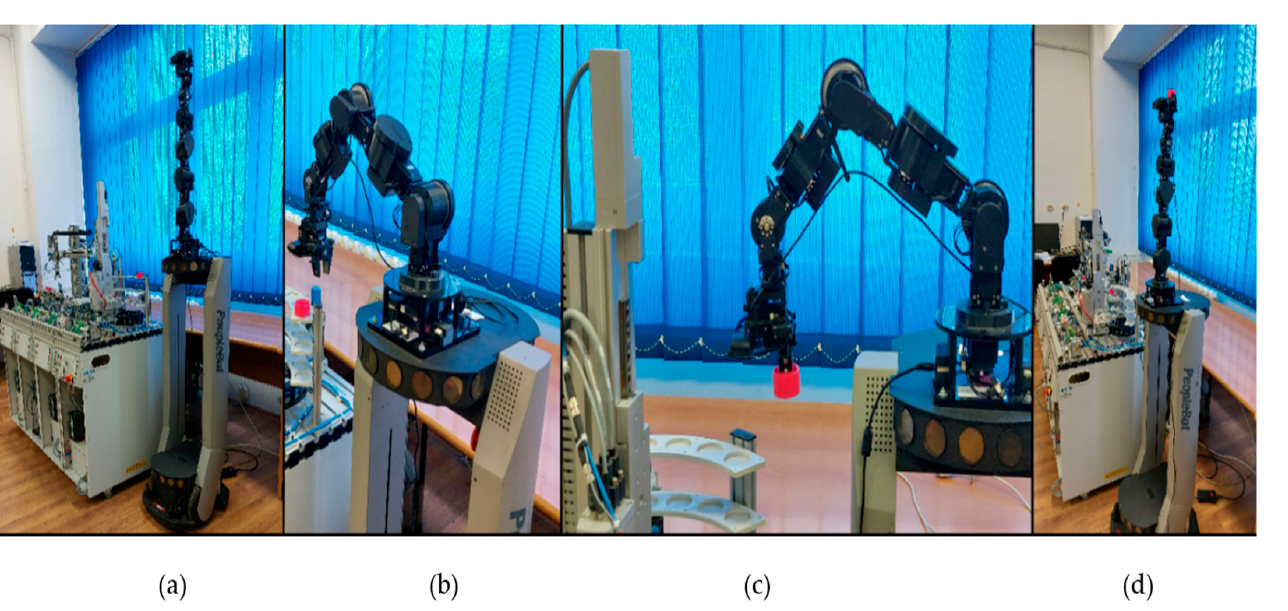
Figure 12. Real-time control of the CAS for picking up workpieces with the following order: ( a ) home position, ( b ) scanning position ( c ) picking up object ( d ) home position with the workpiece picked up in the gripper.